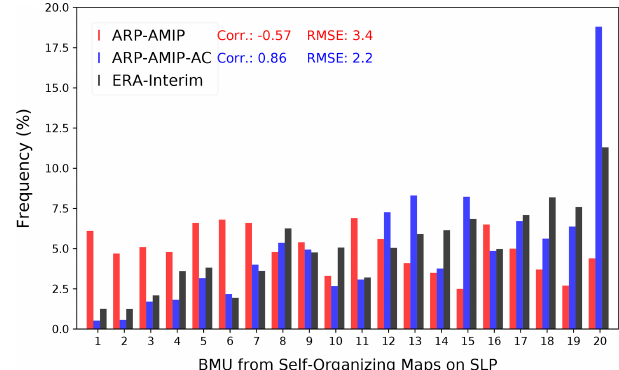
Figure 3. Best-matching-unit (BMU) relative frequency (%) of ARP-AMIP (red), ARP-AMIP-AC (blue) and ERA-I (black) on daily SLP map over the 1981–2010 period. Root mean square er- rors and Pearson correlation coefficient with respect to ERA-I BMU frequencies are shown to the right of the